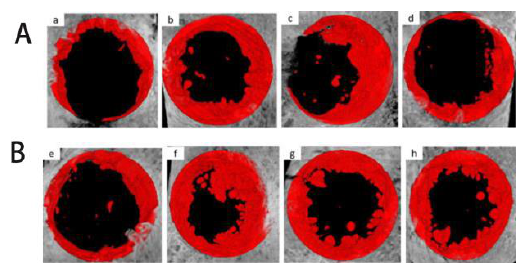
Figure 7. Micro-CT images: ( A ) 4 weeks after surgery; ( B ) 8 weeks after surgery; ( a , e ) Gel/Alg group; ( b , f ) 200 μM AgNP–Gel/Alg group; ( c , g ) 400 μM AgNP–Gel/Alg group; ( d , h ) 600 μM AgNP–Gel/Alg group.